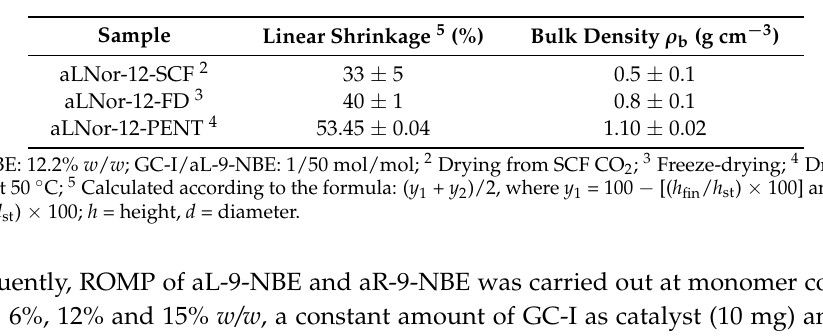
Table 3. Comparison of gels with different drying methods. 1.